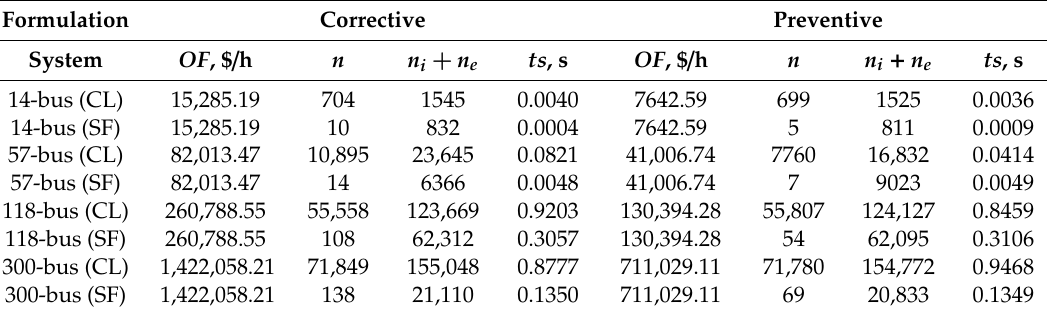
Table 5. Simulation results using di ff erent power